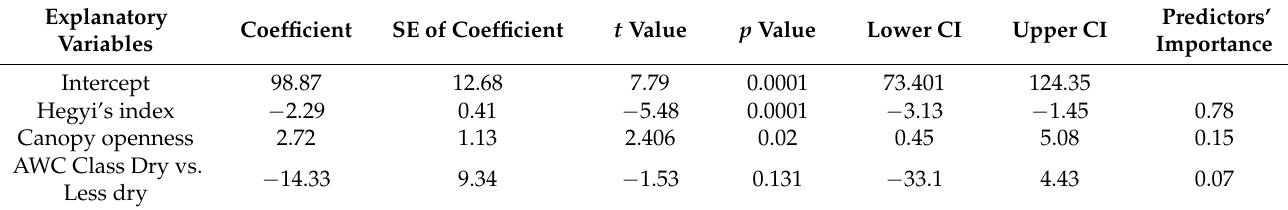
Table 4. Result of regression analysis on the influence of neighborhood competition, light availability, and water availability on mean basal area increment of the beech trees (SE = standard error, CI = confidence interval at 95%) (Adjusted R 2 = 0.41, N = 56). Predictors’ importance ranged from 0 to 1, with higher values signifies higher importance. The predictor or explanatory variable’s importance is the residual sum of the squares with the predictor removed from the model, normalized so that the importance values sum to